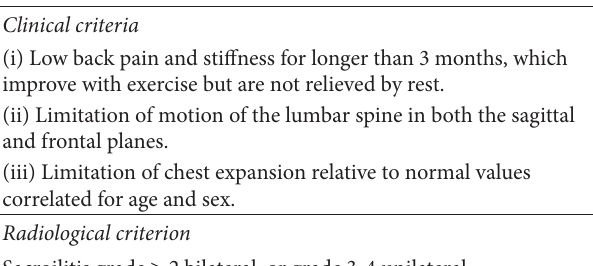
Table 1: Modified New York criteria 1984 for ankylosing spondylitis